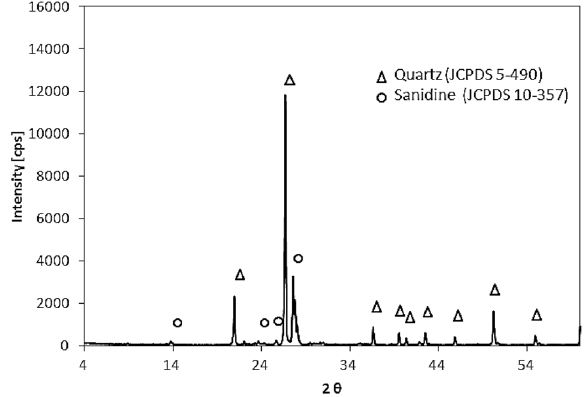
Fig. 1 Histograms of the ratios between concentrations measured and CTC for the three investigated depths